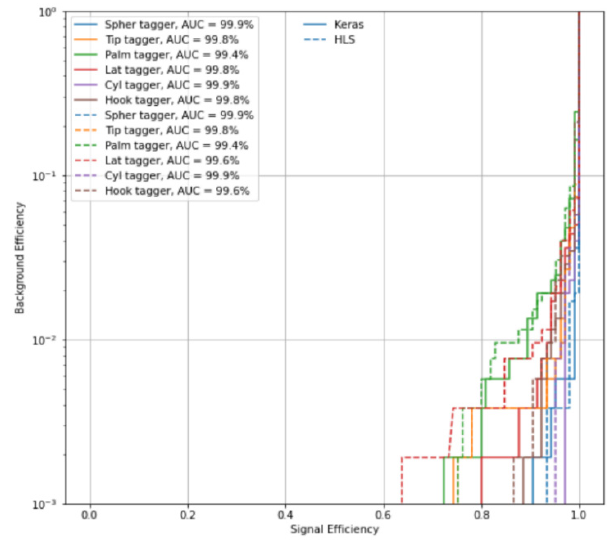
Figure 11. ROC curve for Keras and HLS (six categories).